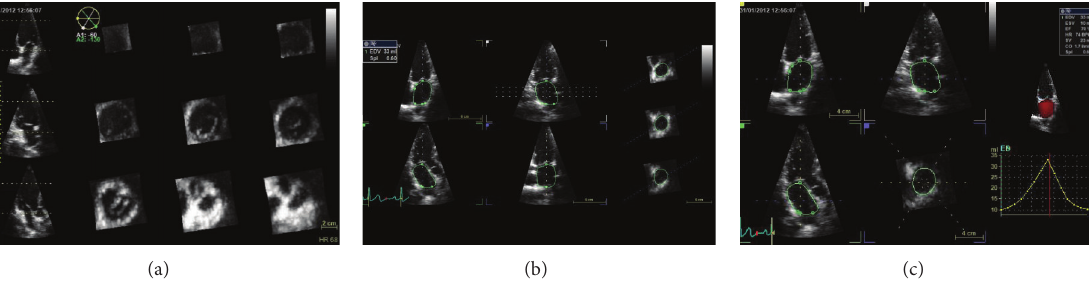
Figure 7: Left atrial volumes by LVQ Auto 4D echocardiography. (a) Left atrial full-volume data sets are acquired. (b) After manually initializing one point to identify the mitral valve plane and another point for the centre of LA roof, the program automatically identifies the endocardial surface both in end-systole and in end-diastole. (c) Atrial maximum (max) and minimum (min) volumes are obtained and displayed in curve, in numeric values, and in 3D image (in red).